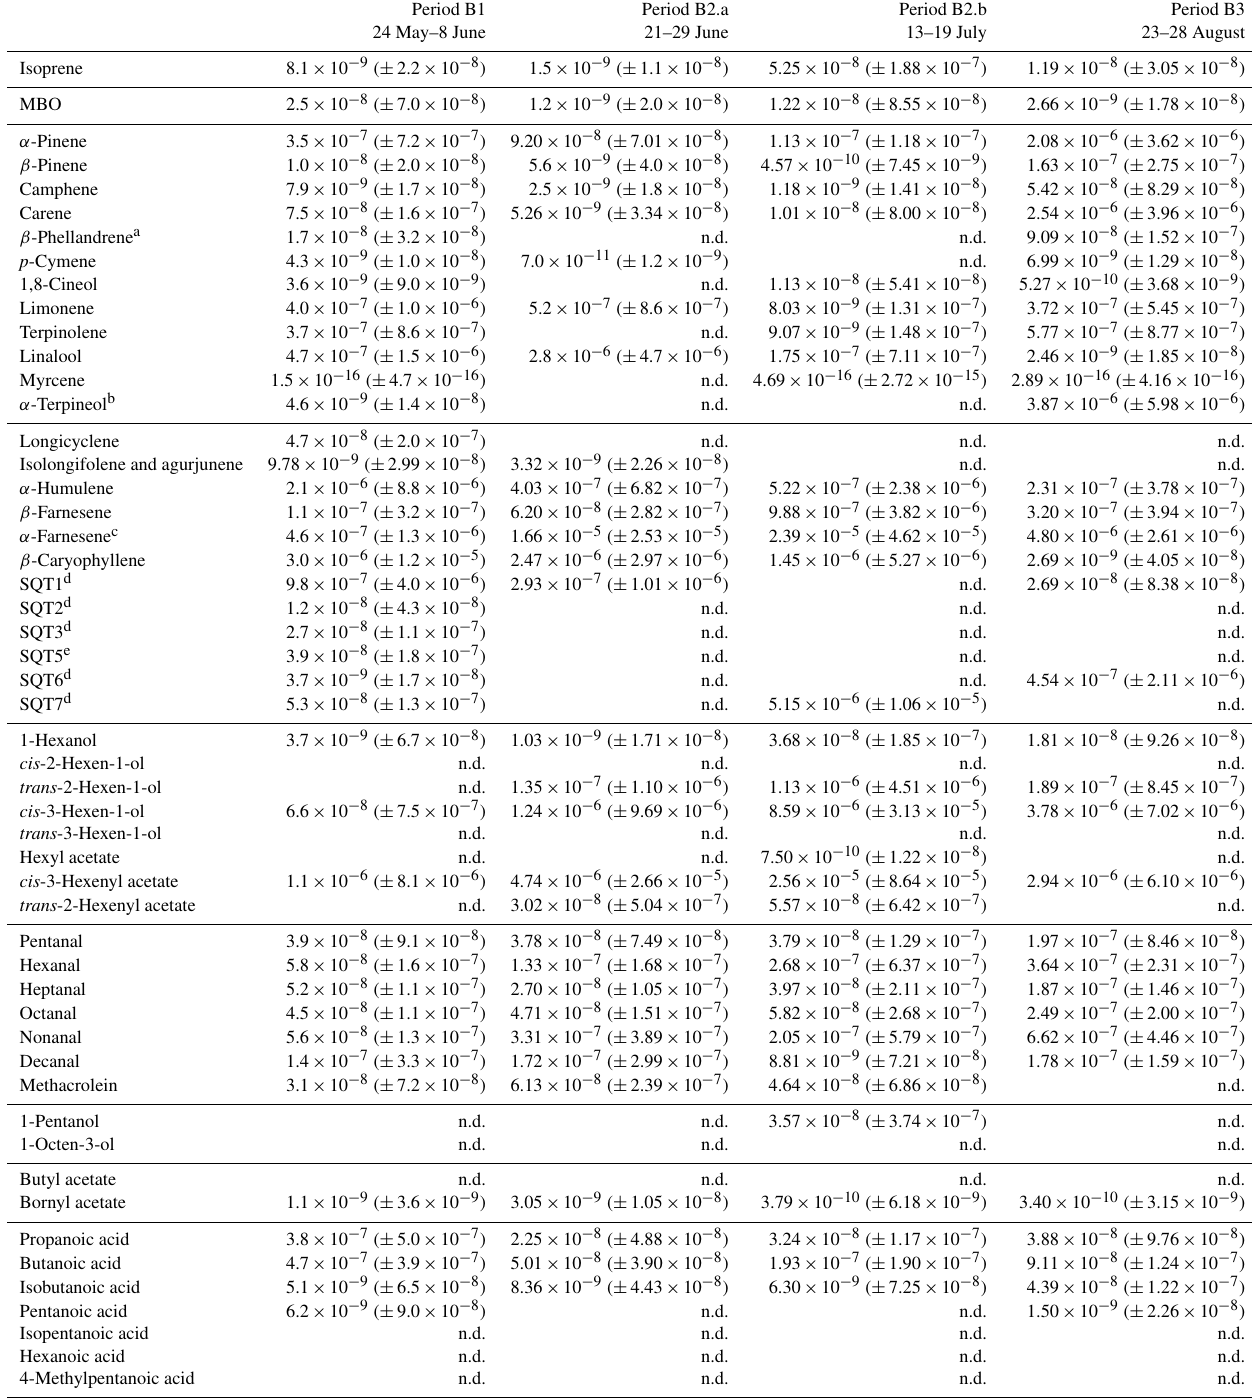
Table D3. Averages of individual compounds’ OH reactivity of the emissions, OHRE (m 3 s − 2 g − 1 for the different measurement periods for birch; “n.d.” means “not